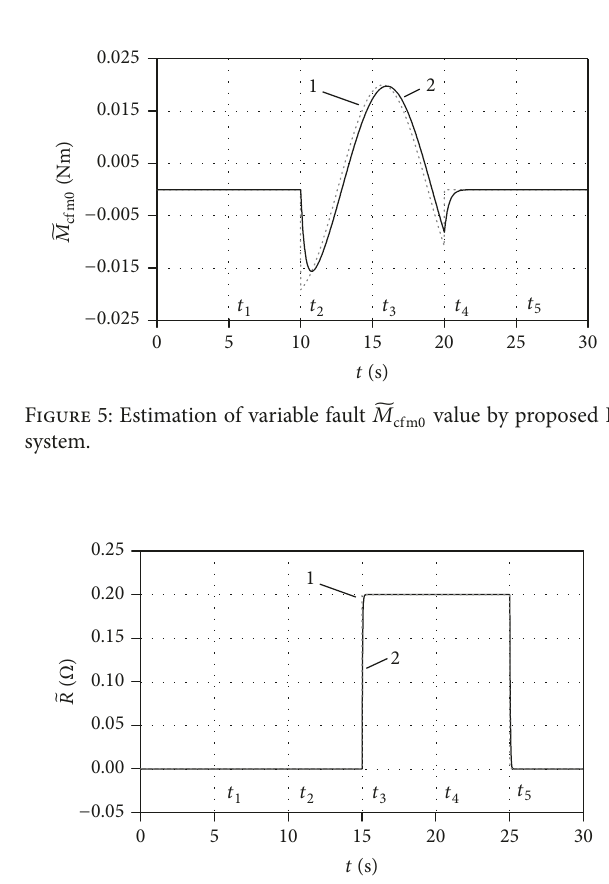
̃𝑅 value by proposed FI